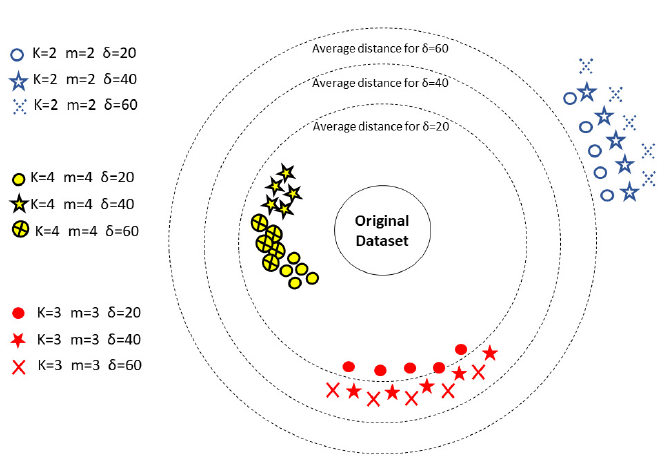
Figure 5. Tree edit distance